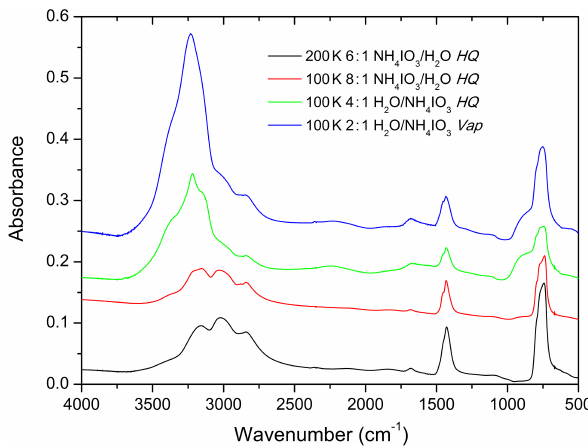
Figure 3. Mid-IR transmission spectra of pure NH 4 IO 3 and H 2 O / NH 4 IO 3 ice mixtures generated at different